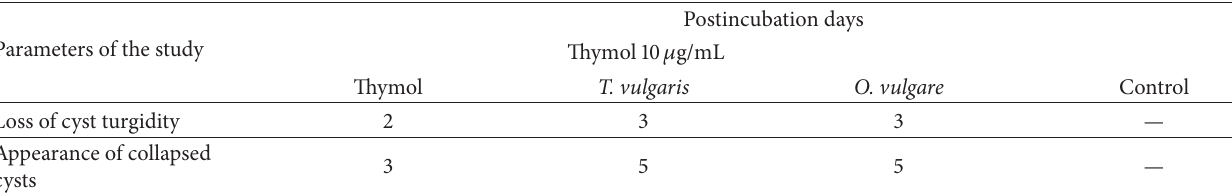
Table 3: Time of appearance (days p.i.) of different indicators of tissue damage on E. granulosus murine cysts, after their incubation with thymol and T. vulgaris and O. vulgare essential oils, under in vitro conditions. Postincubation days Parameters of the study Thymol 10 𝜇 g/mL Thymol T. vulgaris O. vulgare Control Loss of cyst turgidity